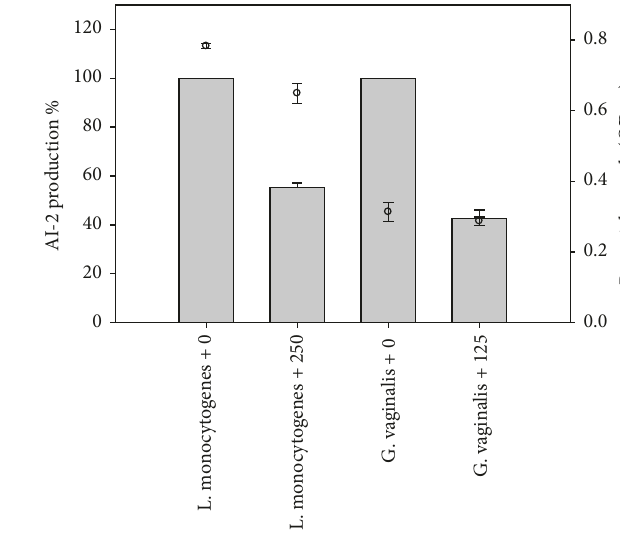
Figure 7: Inhibition of AI-2 production by L. monocytogenes and G. vaginalis in the presence of 250 and 125 𝜇 g/mL of benzoyl peroxide. AI-2 production % (gray colour); bacterial growth (OD 585 ) ( e